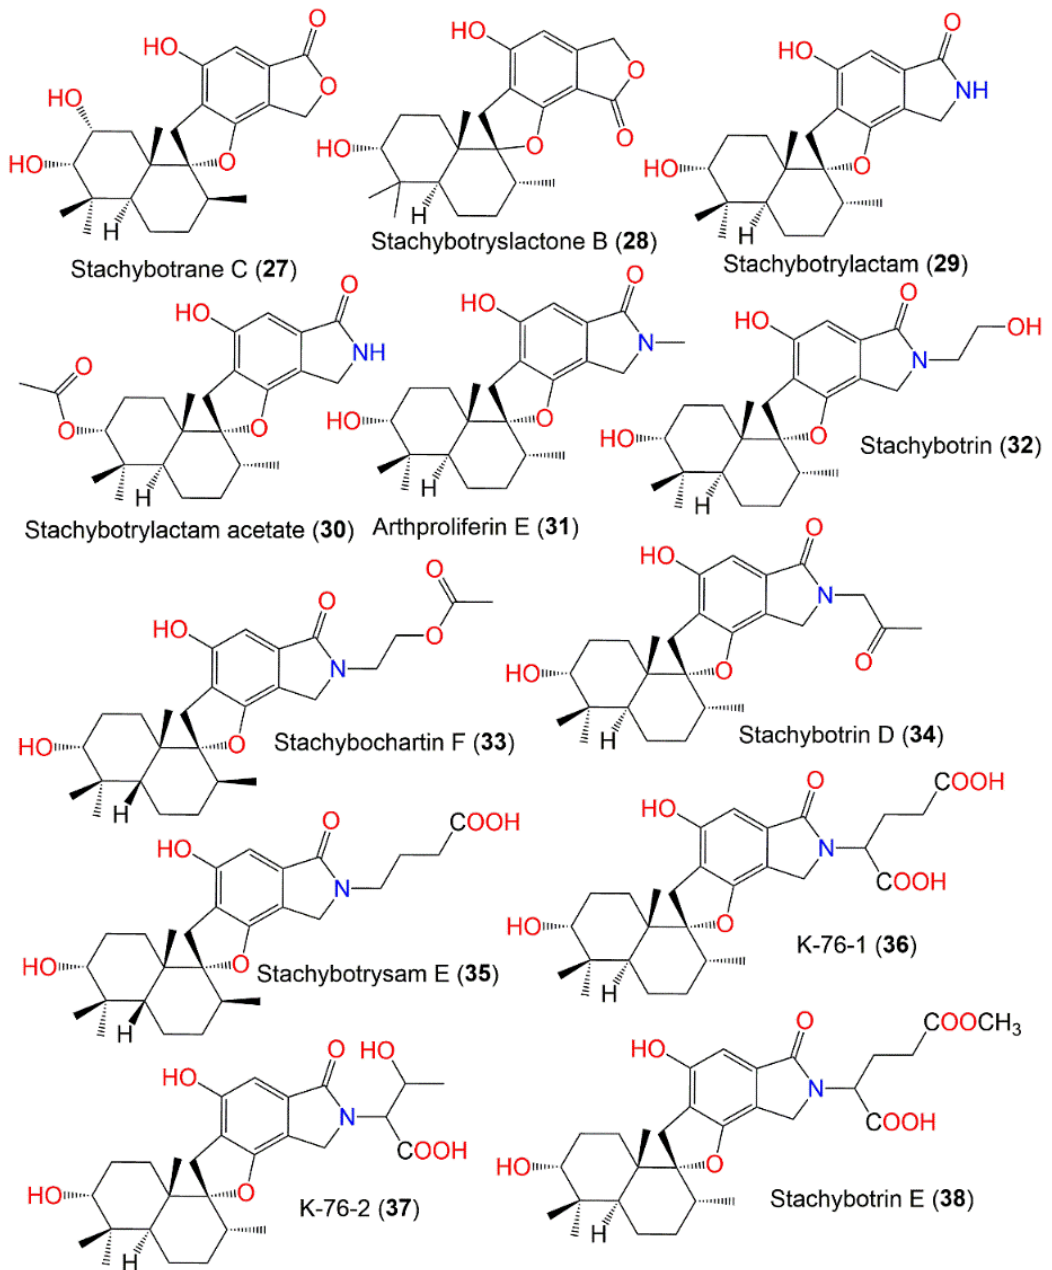
Figure 3. Structures of phenylspirodrimane derivatives ( 27 – 38 ) reported from S . chartarum .